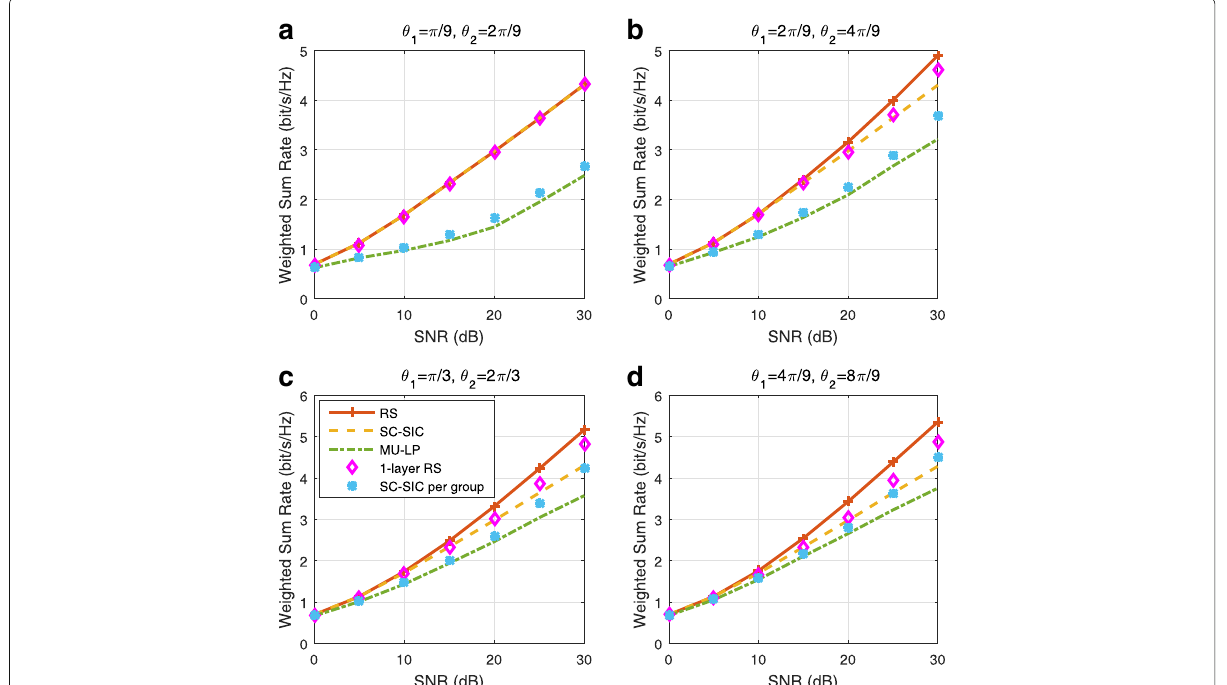
Fig. 56 Weightedsumrateversus SNR comparison of different strategies for overloaded three-user deployment with imperfect CSIT, γ 1 = 1, γ 2 = 0.3, u 1 = 0.4, u 2 = 0.3, u 3 = 0.3, N t = 2, r th = [0.02,0.08,0.19,0.3,0.4,0.4,0.4] bit/s/Hz. a θ 1 = π/ 9, θ 2 = 2 π/ 9. b θ 1 = 2 π/ 9, θ 2 = 4 π/ 9. c θ 1 = π/ 3, θ 2 = 2 π/ 3.